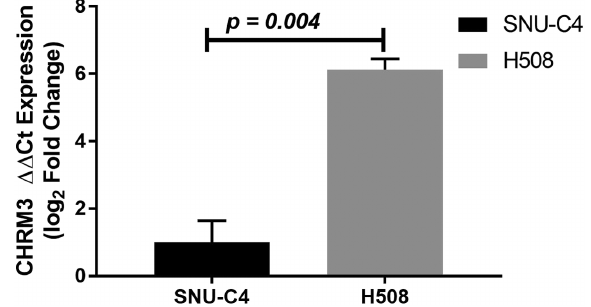
Figure 1. Relative expression level of CHRM3 for H508 cells compared with SNU-C4 cell. The relative expression level of the CHRM3 in each cell was measured by RT-qPCR, and was normalized by the expression level of GAPDH and β -actin . Statistical analysis was performed with Student’s t -test. Values represent mean ± SEM (n = 3). RT-qPCR, real-time quantitative polymerase chain reaction; SEM, standard error of